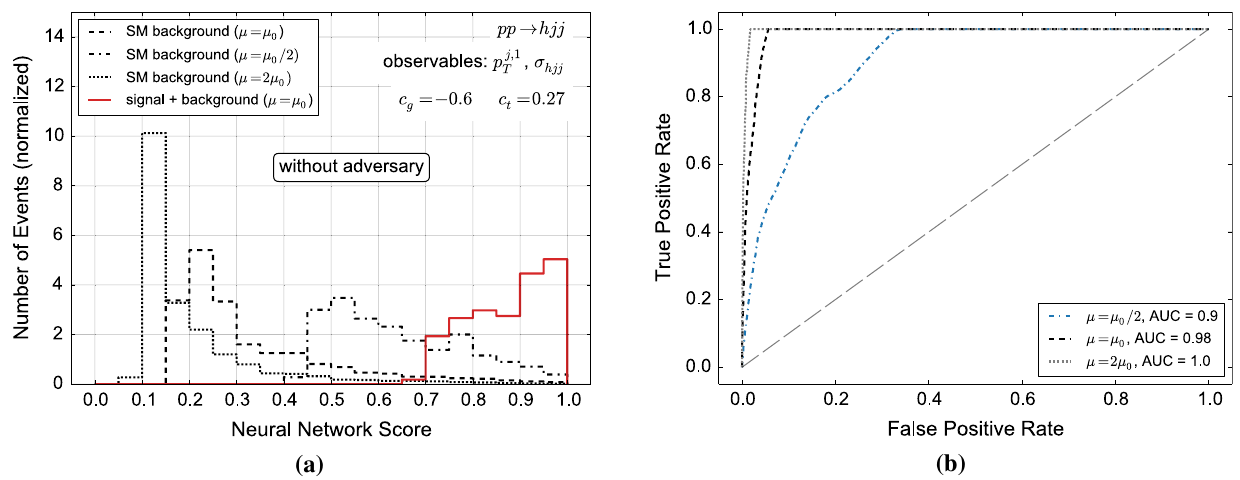
Fig. 4 Distribution of NN scores ( a ) and associated ROC curve ( b ) for background-only and signal + background event samples. The classification has been performed using only the discriminator. If the area under curve (AUC) is larger than 0.5, discrimination is possible